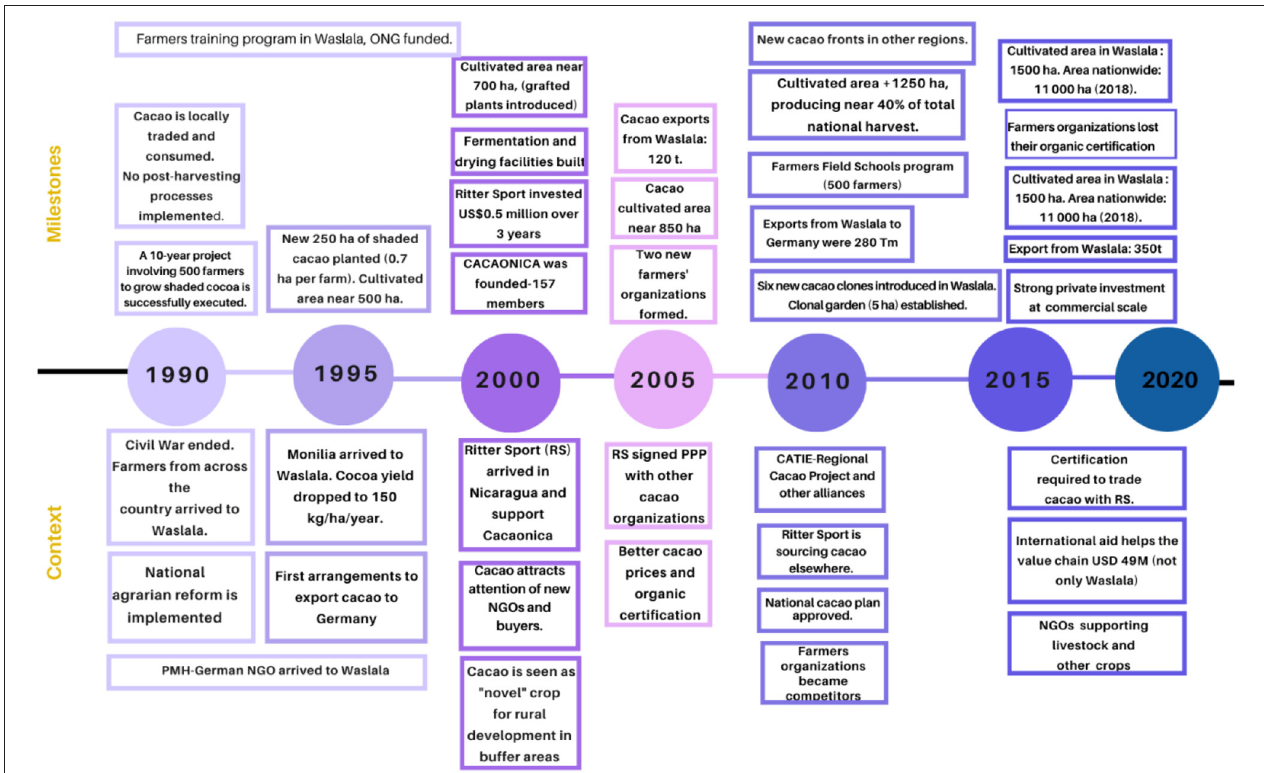
FIGURE 3 | Timeline (milestones and context) of cocoa cultivation in Waslala, Nicaragua.